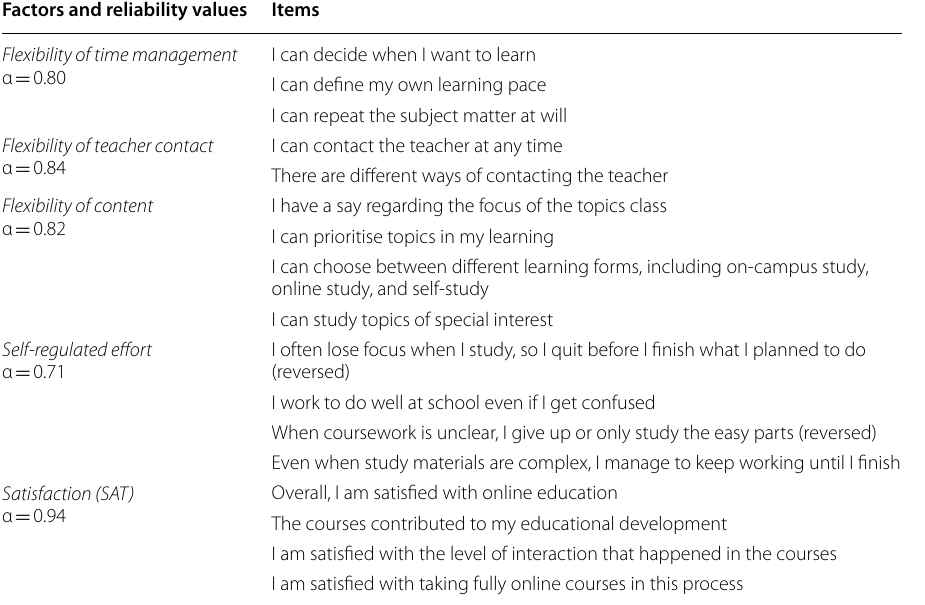
Table 2 Factors, items and reliability values Factors and reliability values